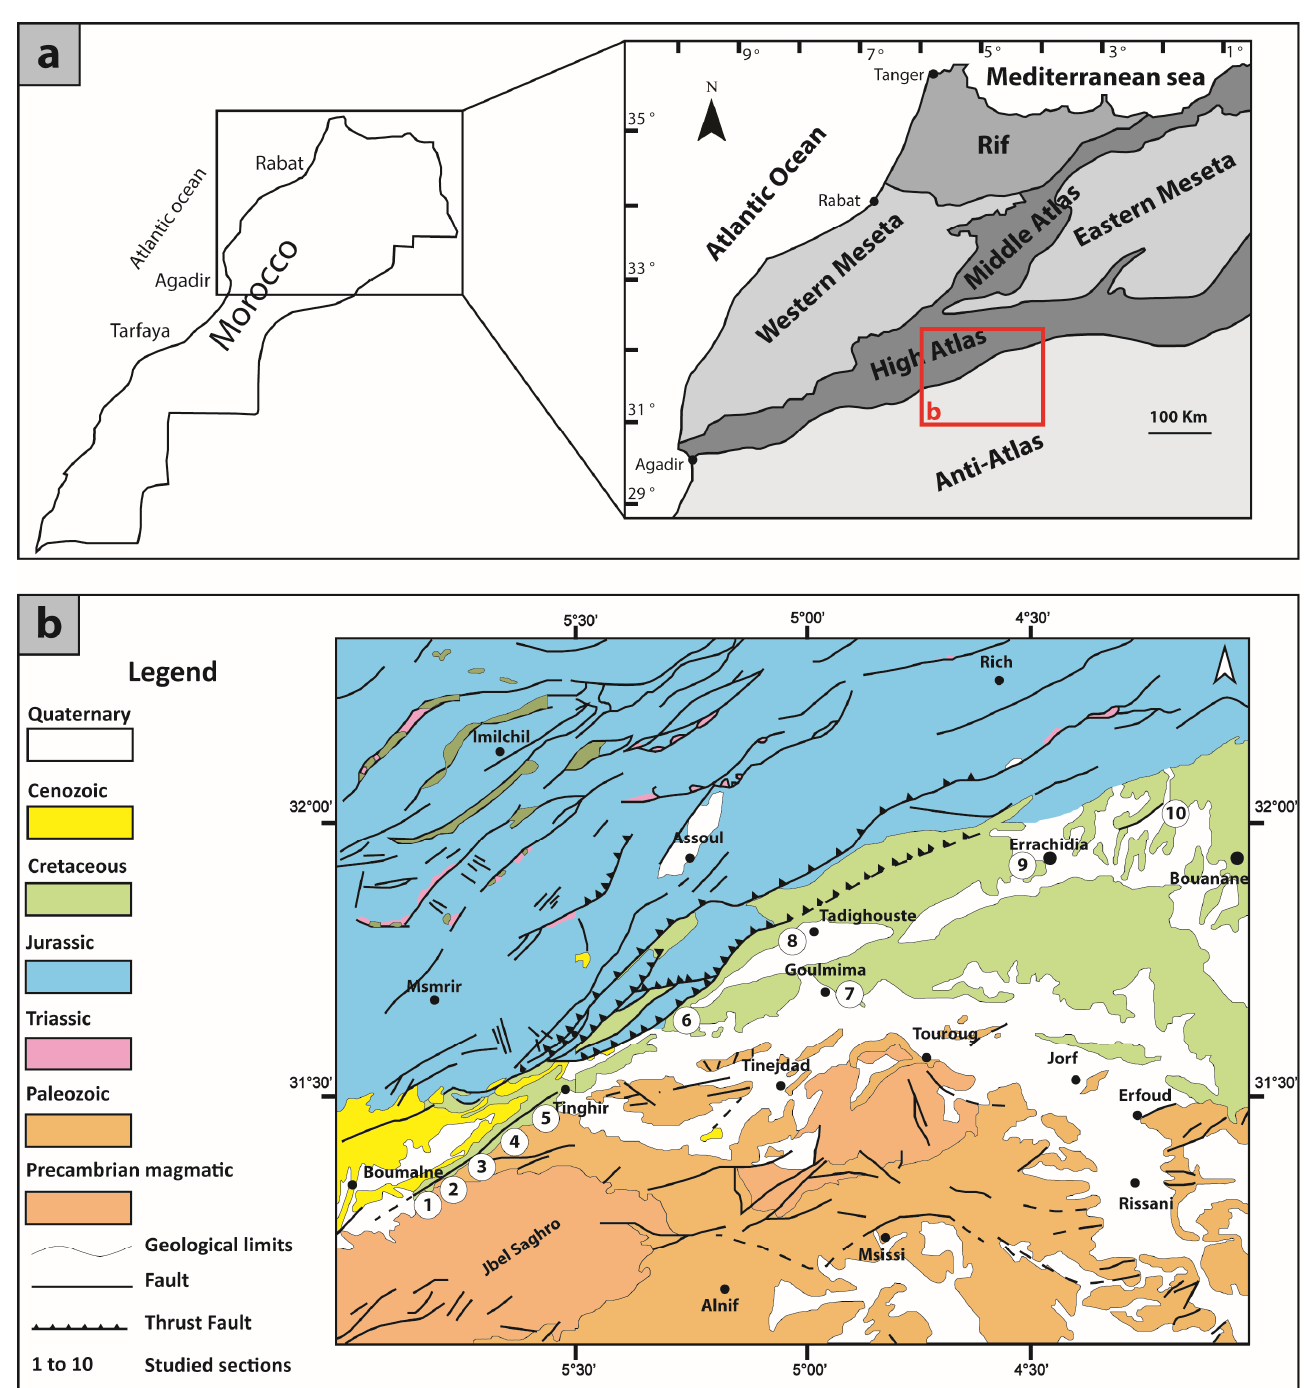
Figure 1. Geotectonic domains of Morocco and the location of the study area ( a ). Geological map showing the location of the studied sections ( b ) ([23], simplified).